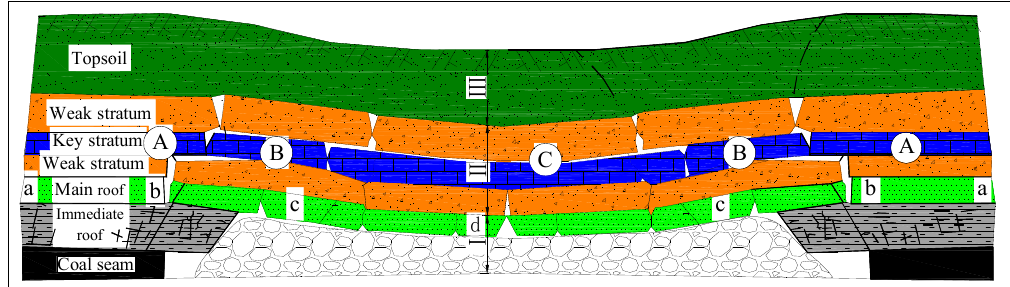
Figure 1. The “three horizontal zones” and “three vertical zones” of overburden strata movement (Qian et al, 2003 [17]). A—abutment pressure affecting area (a–b); B—separation area (b–c); C—recompaction area (c–d); I—caving zone; II—fracture zone; III—bending sagging zone.